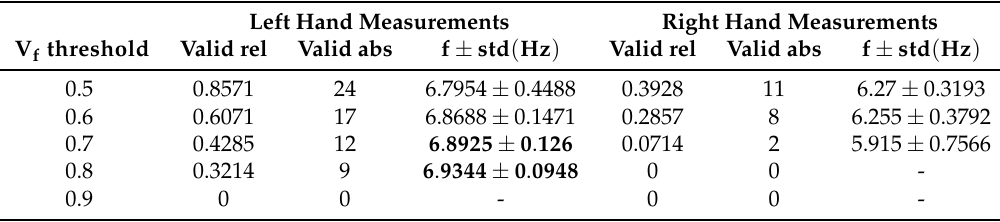
Table 5. Results of repeated measurements with the Rehapiano of a PD subject. Left Hand Measurements Right Hand Measurements V f